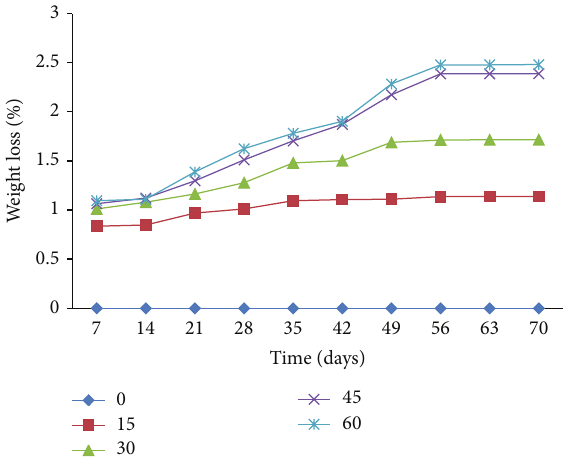
Figure 7: Weight loss in the presence of